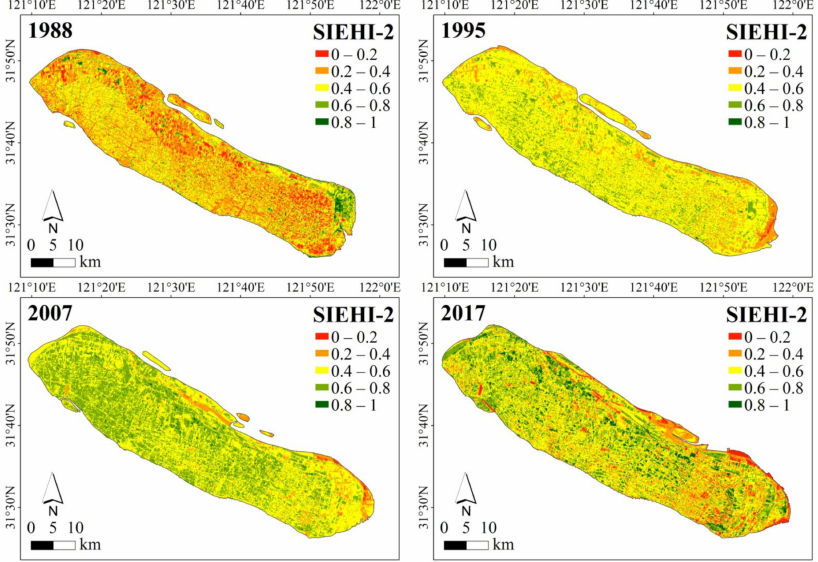
Figure 9. Maps of SIEHI-2 in the four years: SIEHI-2: Part 2 of the sandy island ecosystem health